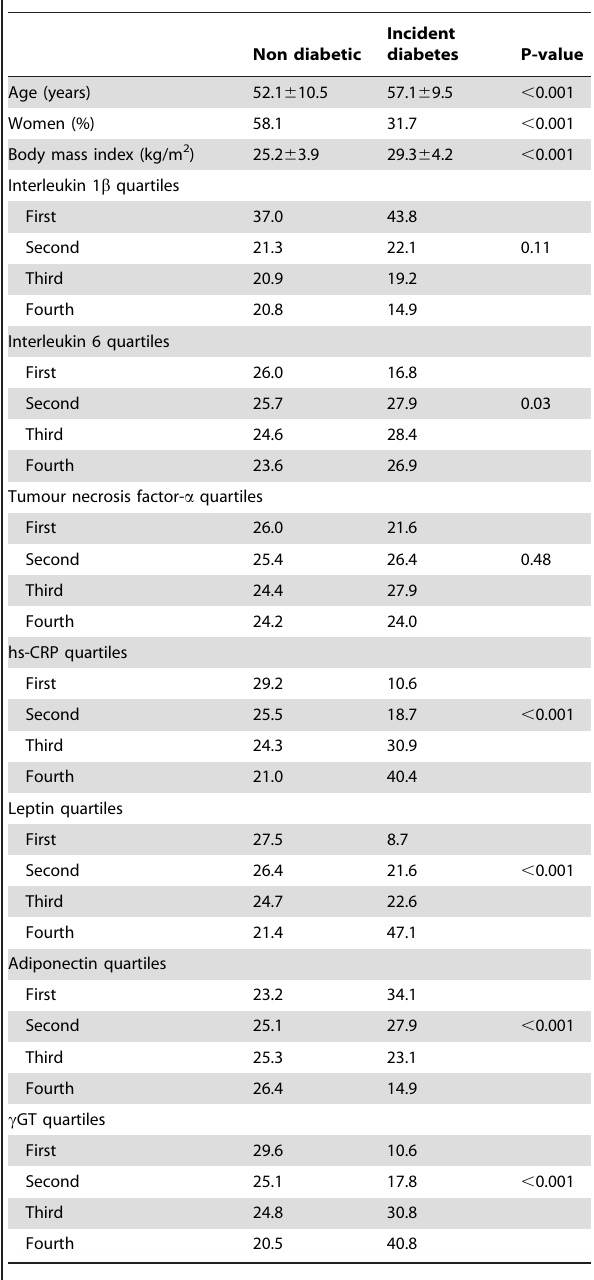
Table 1. Baseline levels of adipocytokine, hepatic and inflammatory markers for participants who developed type 2 diabetes (n =208) and those who remained free from it (n=3634) after 5 years of